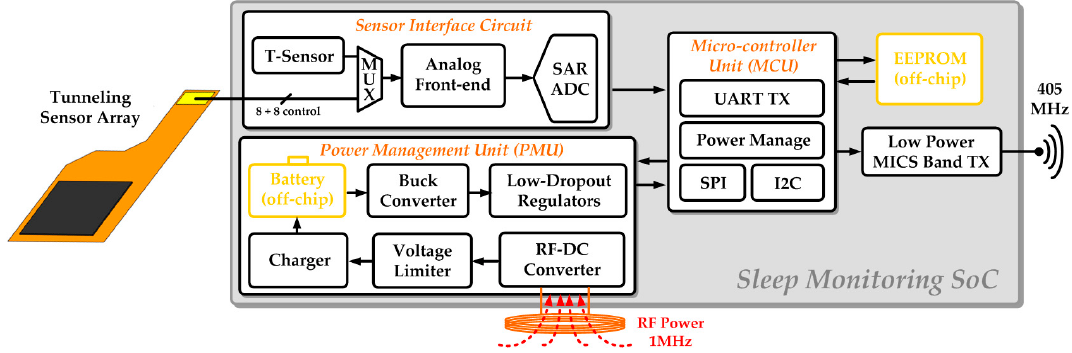
Figure 4. Block diagram of the proposed SoC enabled monitoring system.